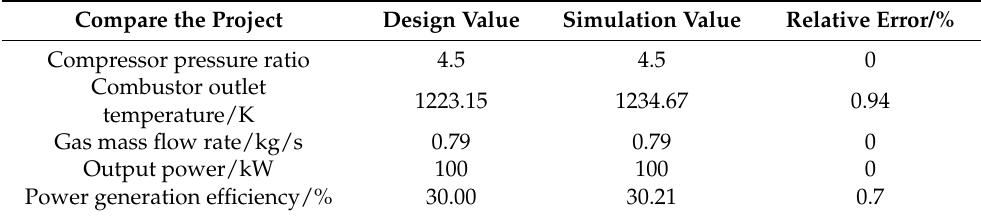
Table 4. Comparison between T100 design parameters and simulated values.